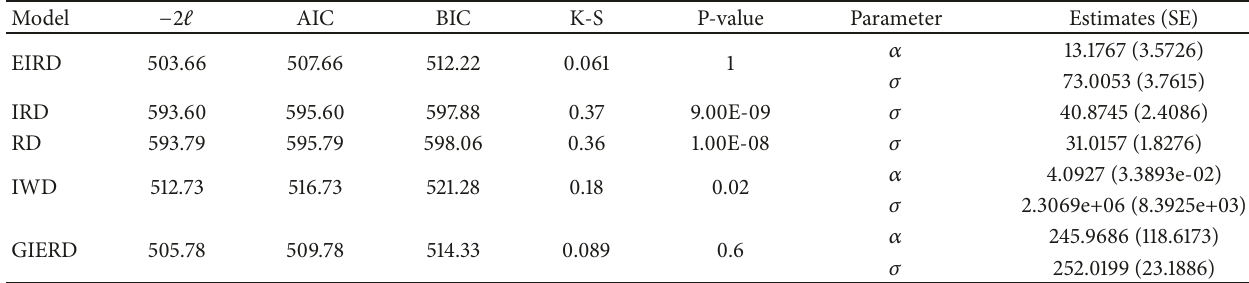
Table 8: Statistics of the goodness of fit, MLE, and standard errors (SE) for Tcs.